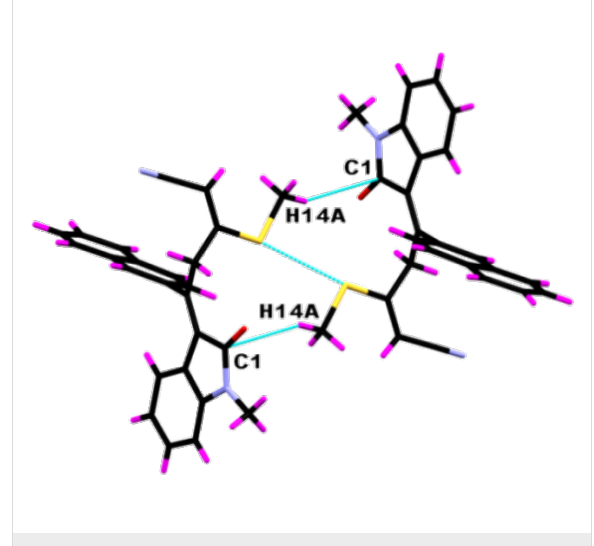
Figure 3: Centrosymmetric dimer of 8yc bound by a pair of weak C − H … π intermolecular interactions (symm. op. 2 − x ,1 − y , 2 − z ). the presence of weak noncovalent interactions between the two molecules of 8yc . The value of electron density ( ρ ), Laplacian of the electron density ( ρ bcp ), bond ellipticity ( ε ), electron density ( ρ ), and total energy density (H) at the bond critical point for all the three interactions are presented in Table 1. As indicated in Table 1, the electron densities for all the three types of interactions at the bond critical point ( ρ bcp ) are less than +0.10 au, which indicates closed-shell hydrogen bonding inter- actions. Additionally, the Laplacians of the electron density ρ bcp in all the three cases are greater than zero, which indi- cates the depletion of electron density in the region of contact between the H … O and H … C atoms. The bond ellipticity ( ε ) measures the extent to which the density is preferentially accu- mulated in a given plane containing the bond path. The ε values for all the three interactions indicate that these are not cylindri- cally symmetrical in